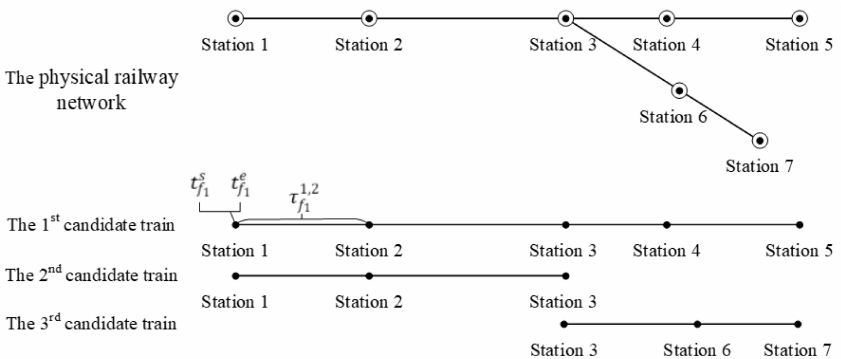
Figure 1. A physical railway network and three candidate